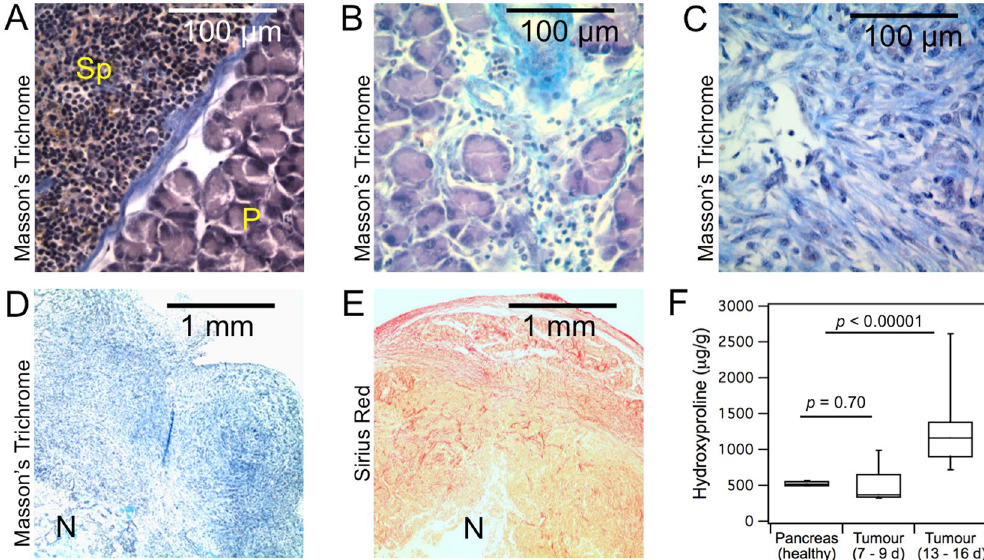
Figure 1. Histology and collagen quantification in pancreatic tumours and adjacent pancreas and spleen in a murine PDAC model. ( A – C ), high magnification images (400x) of tissue stained with Masson’s Trichrome (collagen in blue): ( A ) healthy pancreas (P) and spleen (Sp), ( B ) early tumour (day 8), ( C ) mature tumour (day 14). ( D – E ) low magnification (40x) images of approximately ¼ of a whole mature tumour showing heterogeneous distribution of collagen: ( D ) Masson’s Trichrome staining (collagen in blue), ( E ) Picro-Sirius red (collagen in red). N = necrosis. ( F ) quantitative analysis of hydroxyproline (surrogate for collagen) in healthy pancreas (sham control, n = 5), early tumours (days 7–9, n = 9) and mature tumours (days 13–16, n =